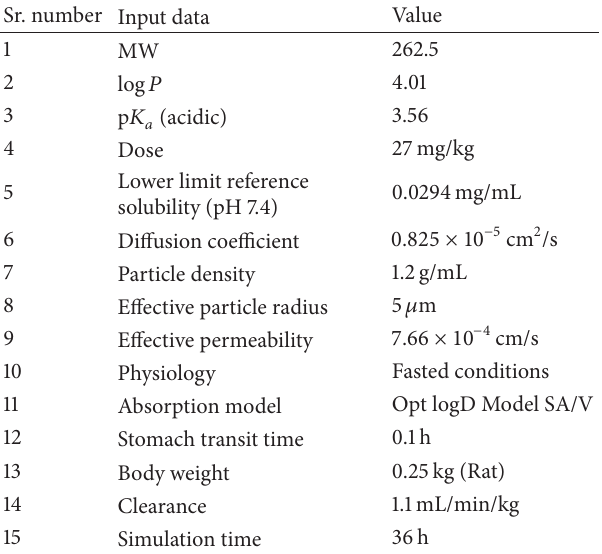
Table 1: The input parameters used during the simulation of plasma concentrations versus time profiles of fenofibric acid in rat